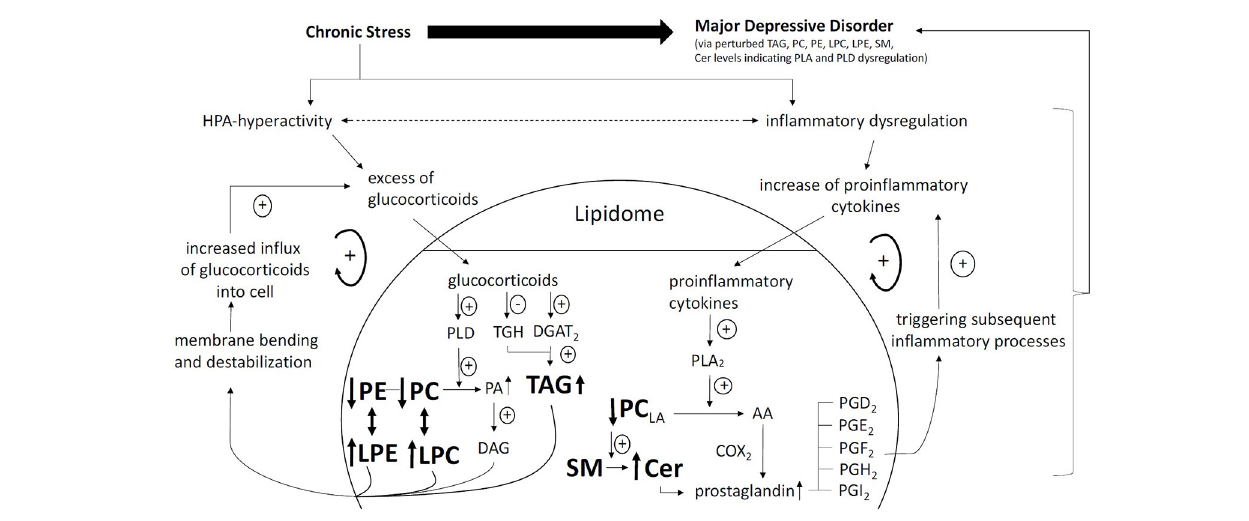
FIGURE 2 | Pathway linking chronic stress, HPA hyperactivity, increased inflammation, lipidomic dysregulation, and development of MDD. Glucocorticoid positive spiral pathway A: Chronic stress leads to HPA hyperactivity. Increased levels of glucocorticoids increase PLD activity ( 48). Increased PLD activity leads to increased turnover of phosphatidylcholines (PC) and phosphatidylethanolamine (PE) to phosphatidic acid (PA) and also lysophosphatidylcholine (LPC) and lysophatidylethanolamine (LPE). Due to is chemical properties, PA is swiftly converted to diacylglycerol (DAG). DAG, LPC, and LPE cause membrane bending and destabilization allowing more influx of glucocorticoids into the cell. Glucocorticoid positive spiral pathway B: Increased levels of glucocorticoids decrease triacylglycerol hydrolase (TGH) expression. Increased levels of glucocorticoids increase triacylglycerol (TAG) biosynthesis via increase of (diacylglycerol acyltransferase 2) DGAT2. Reduced TGH expression and increased TAG biosynthesis lead to increased levels of TAG ( 49). TAG in turn is related to increased levels of glucocorticoids. Inflammatory positive spiral pathway: Chronic stress leads to inflammatory dysregulation. An excess of proinflammatory cytokines and phase reactants increase phospholipase A2 (PLA2) ( 50). Increased PLA2 activity leads to increased turnover of linoleic acid (LA) containing phosphatidylcholines (PC LA ) to arachidonic acid (AA). AA is subsequently converted to prostaglandins (PG) of which the series 2 is proinflammatory (e.g., PGA2, PGD2, PGE2, PGF2, PGH2, PGI2). PG further increase inflammatory reactions ( 40). PC degradation is associated with SM-Cer turn over further increasing PG levels (22). Lipid Nomenclature: following annotations are used: Lipid class < sum of carbon atoms > : < sum of double bonds > ; < sum of hydroxyl groups > , e.g., SM 34:1;2 signifies a SM species with 34 carbon atoms, 1 double bond and 2 hydroxyl groups in the ceramide backbone. Lipid molecular subspecies annotation ( 35) contains additional information about the exact identity of their fatty acids, the exact position of which cannot be discriminated in relation to the glycerol backbone ( sn -1 or sn -2). This is indicated by a dash: “-.” For